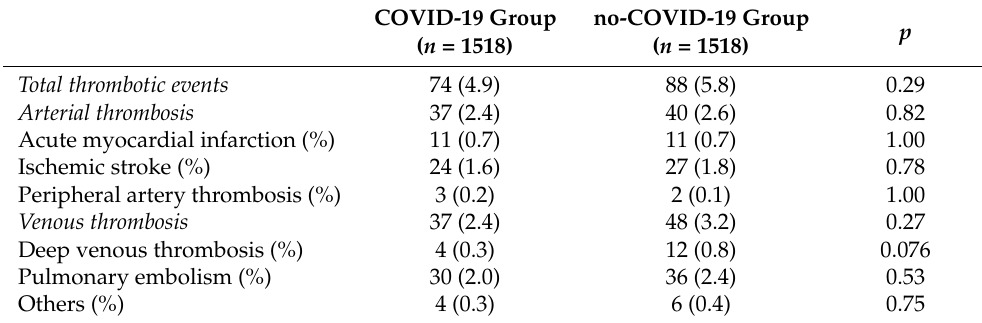
Table 4. Arterial and venous thrombosis in propensity score-matched subgroups of